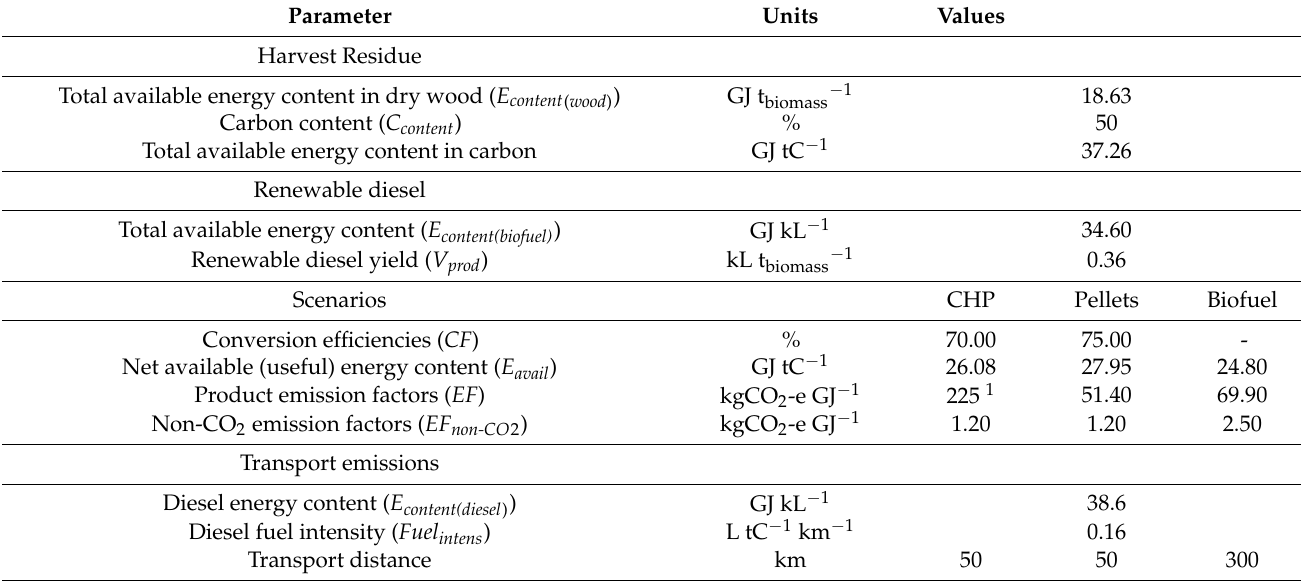
Table 2. Summary of main parameters used in the calculation of emissions avoided (Equations